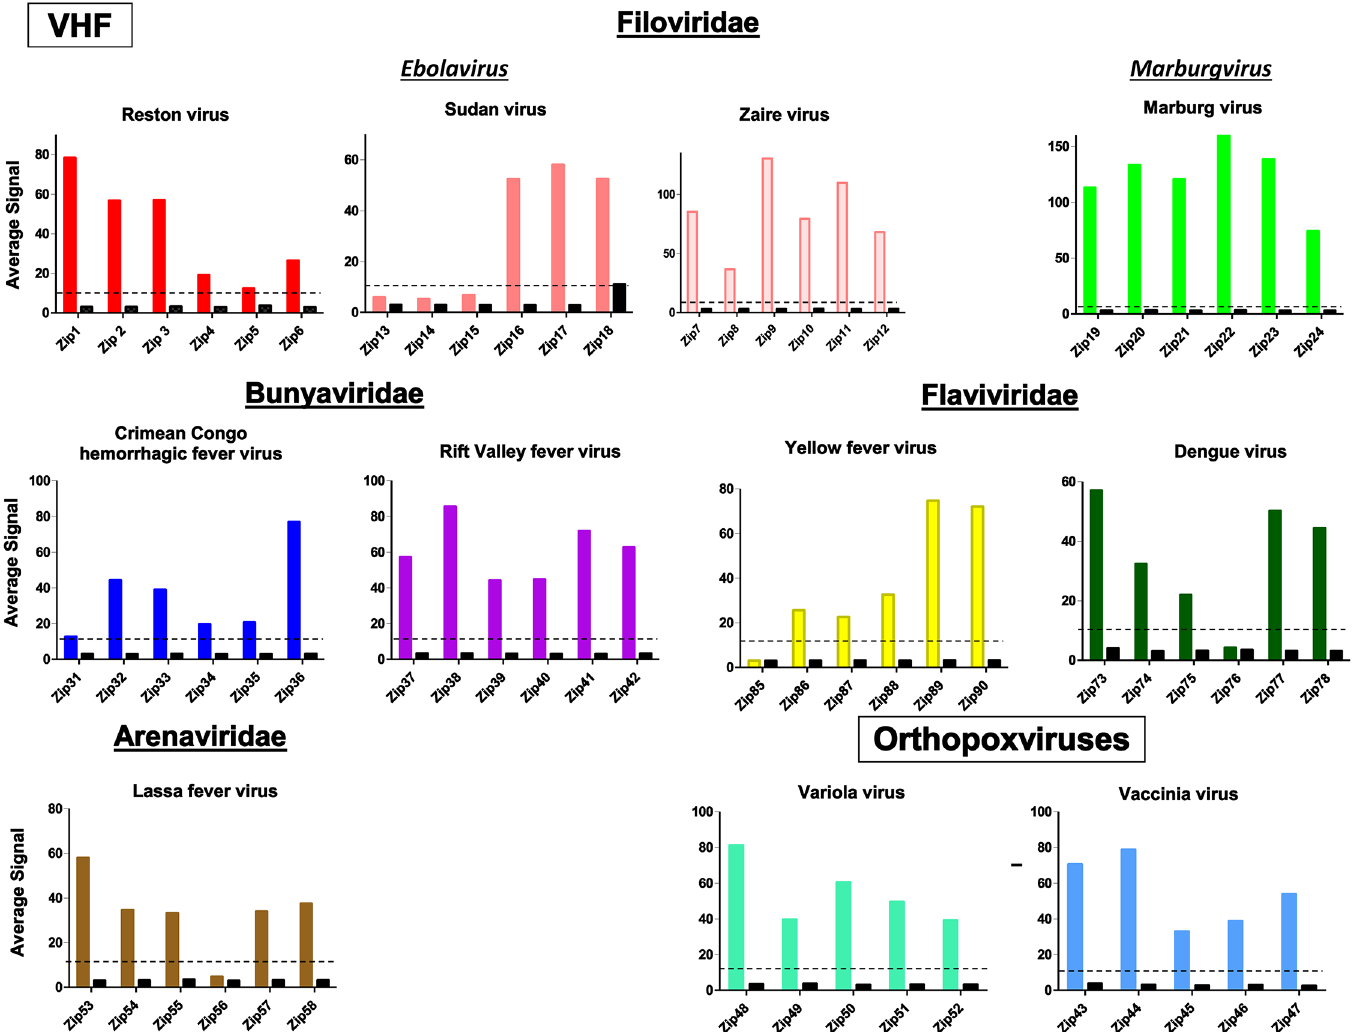
Fig 2. Comparison of universal array profile of viral RNA/DNA tested for the corresponding zip-codes. Normalized average signal intensity for the zip- codes assigned to each virus are presented. The color bars are the signals obtained with the indicated virus (positives). The black bars are the signals produced by the other ten viruses. A signal was considered positive if the intensity of the zip-code spot was at least 10-fold higher than the uniform background level of fluorescence of the array slide. Although a few other viruses produced low-level positive signals for zip18, this did not result in any false positive results since positive signals from at least two addresses was required for a positive identification. In the future, this issue would be rectified by switching to a different zip-code. The average signal intensity for the positives ranged from 31.2 to 123.4, depending on the virus. The average signal intensity for the negatives ranged from 0.3 to 6.2, thus they were not considered positive